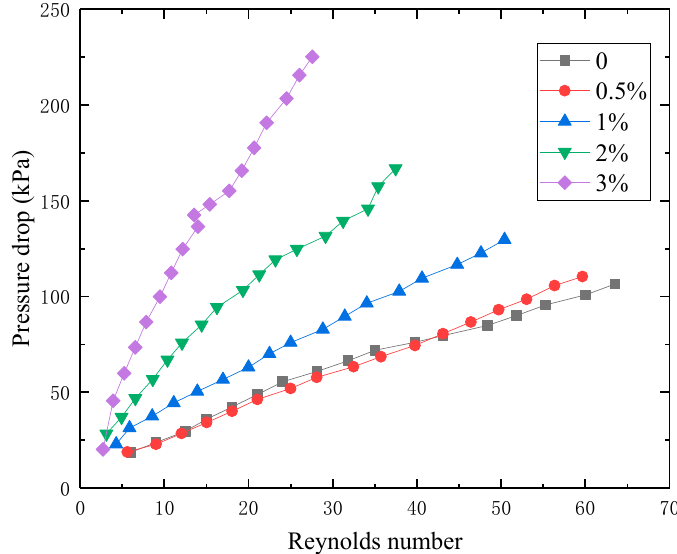
Figure 9. Pressure drop of prepared nanofluid samples at different Reynolds numbers.